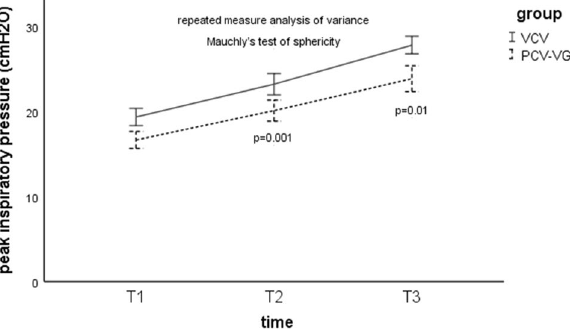
Figure 2. Peak inspiratory pressure in the two groups at different stages of the study. T1, 10 min after induction of anaesthesia in the supine position without pneumothorax; T2, 5 min after OLV commencement; T3, 5 min after complete CO 2 insufflations; VCV volume controlled ventilation, PCV-VG pressure controlled volume guaranteed ventilation. The data was presented as mean (standard